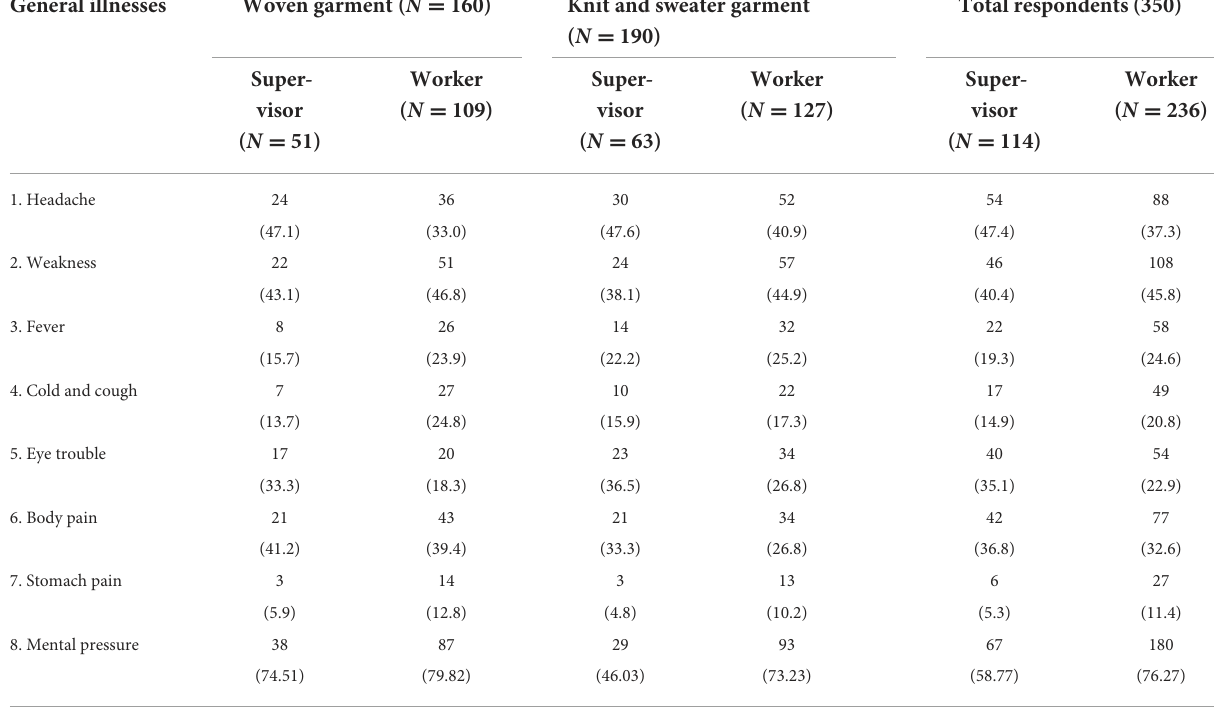
TABLE 12 General illnesses as faced by the different category of respondents ( N = 350). General illnesses Woven garment ( N =